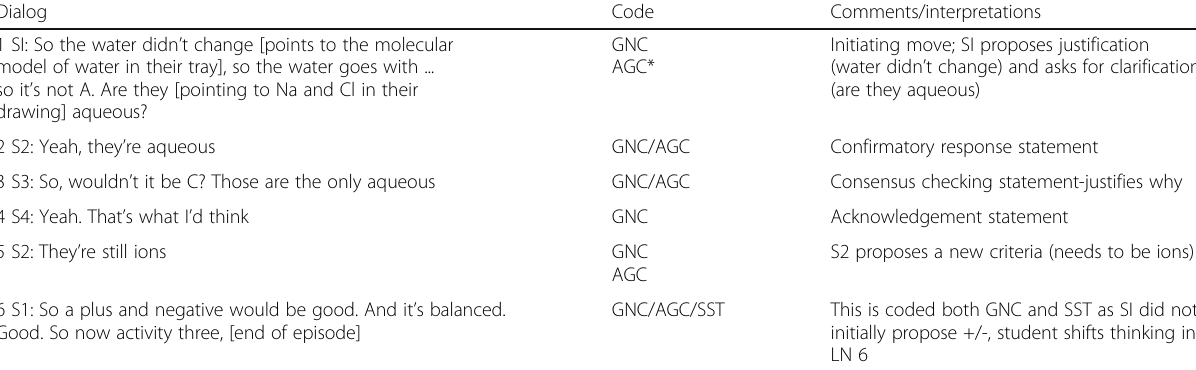
Table 2 Group 1A ’ s dialog on choosing correct equation for the dissolution of NaCl in water Dialog